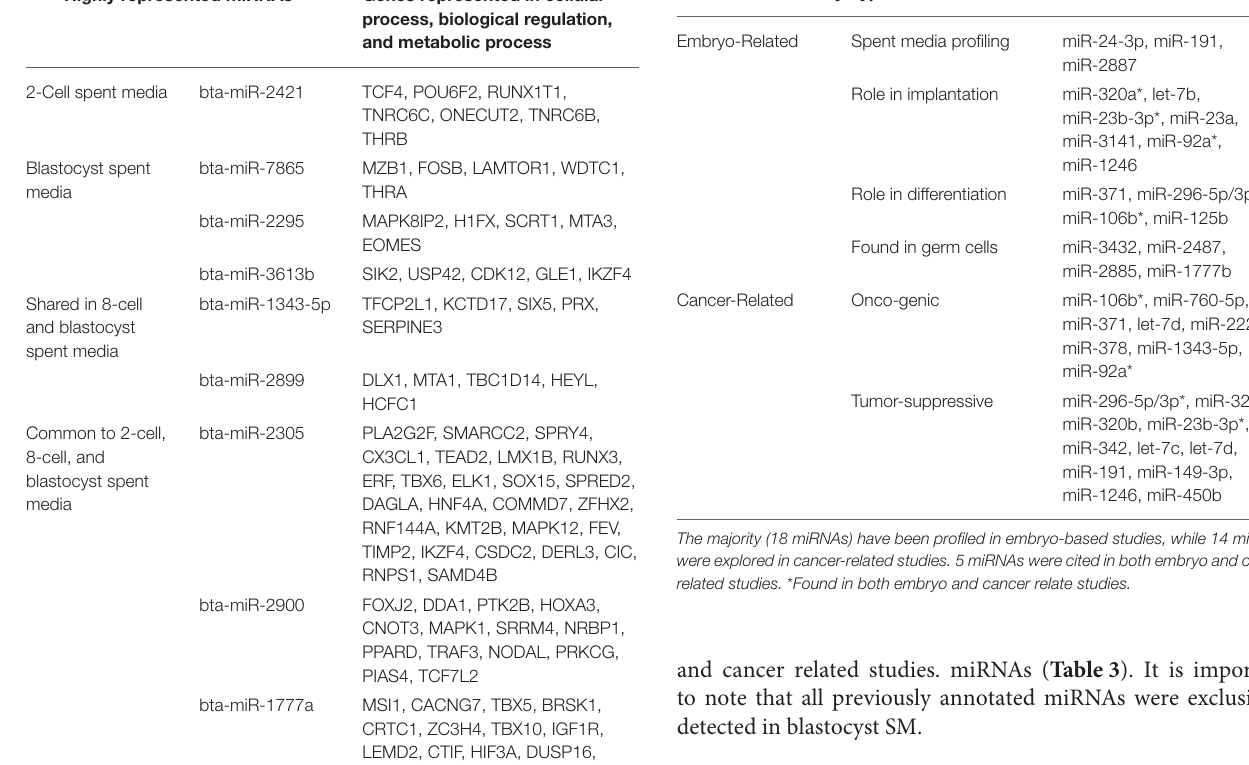
TABLE 3 | List of miRNAs detected in all 3 spent media conditions previously TABLE 2 | miRNA-mRNA targets predicted to have roles in the top 3 biological annotated in pathways represented in gene-set enrichment analysis. Highly represented miRNAs Genes represented in cellular process, biological regulation, and metabolic process